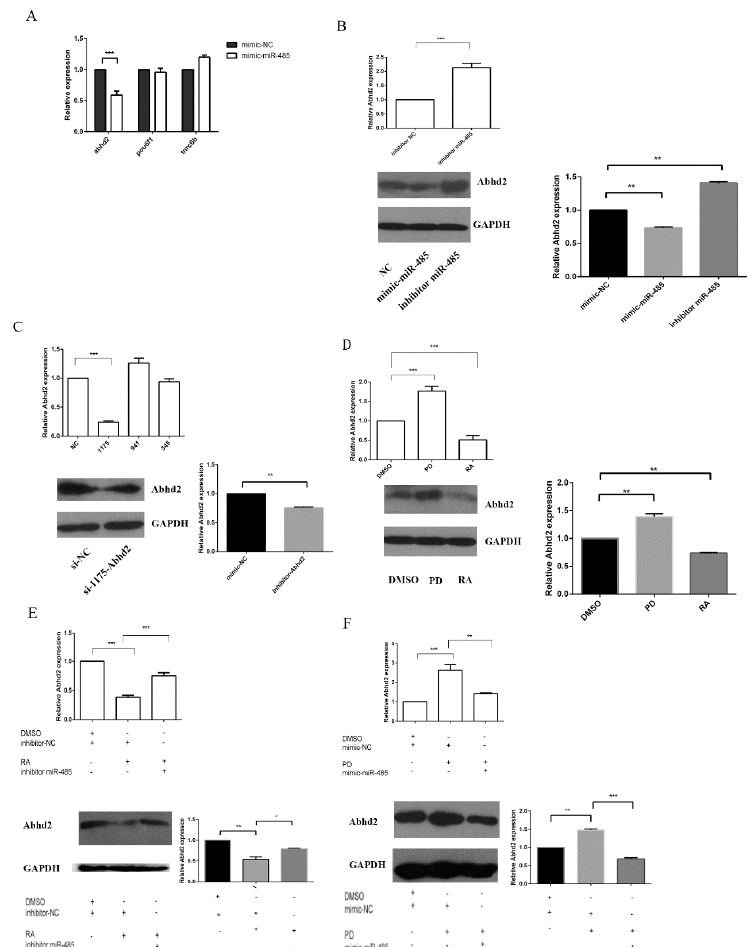
Figure 2. RA, PD and mir-485 influence Abhd2 at both transcriptional level and post-transcriptional level. ( A ) RT-qPCR analysis for the representative genes that may be regulated by miR-485. 36 h after being transfected with mimic NC or mimic-miR-485, F9 ECs were gathered. The relative expression of three genes were determined by qPCR analysis. Gapdh normalized qPCR data were used to show the expression change of the indicated genes. Data are presented as the mean ± SD of three independent experiments (* p < 0.05; ** p < 0.01; *** p < 0.001). ( B ) Up panel: qPCR analysis of Abhd2. Bottom panel: Western Blot analysis of Abhd2. F9 ECs were transfected with miR-485 or inhibitor of miR-485, after 36 h, the Abhd2 expression was determined. Gapdh normalized qPCR and Western Blot data. ( C ) Up panel: qPCR analysis of the effect of the inhibitor of Abhd2. Bottom panel: Western Blot analysis of the effect of the inhibitor of Abhd2. Three kinds of si-Abhd2 were transfected into F9 ECs for 36 h respectively. the expression of Abhd2 were determined by qPCR and Western Blot analysis. Gapdh was used to normalize template levels. The number 1175,941,345 is the code name of three kinds of siRNA of Abhd2 ( D ) Up panel: qPCR analysis of Abhd2 expression in F9 EC cells treated by DMSO, RA or PD for 36 h. Bottom panel: Western Blot analysis of Abhd2 expression in F9 EC cells treated by DMSO, RA or PD for 36 h. ( E ) Up panel: qPCR analysis of Abhd2 expression in F9 EC cells transfected with NC or inhibitor of miR-485. Bottom panel: Western Blot analysis of Abhd2 expression in F9 EC cells transfected with NC or inhibitor of miR-485. After 6h transfection, F9 ECs with the inhibitor of miR-485 or negative control were culture in DMSO or RA contain medium for an additional 30 h. Gapdh was used to normalize template levels. ( F ) Up panel: qPCR analysis of Abhd2 expression in F9 EC cells transfected with NC or mimic of miR-485. Bottom panel: Western Blot analysis of Abhd2 expression in F9 EC cells transfected with NC or mimic of miR-485. After 6h transfection, F9 ECs with the mimic of miR-485 or negative control were culture in DMSO or PD contain medium for an additional 30 h. Gapdh was used to normalize template levels. and for Western Blot, Gapdh was used to normalize template levels. The inhibitor NC is same as mimic